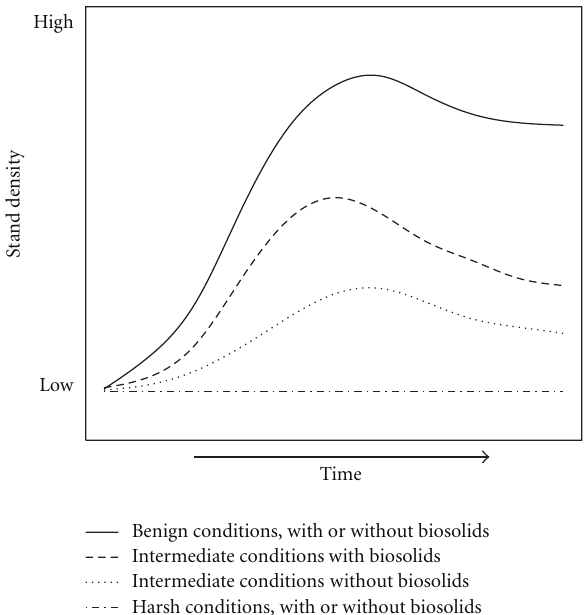
Figure 5: A conceptual model showing the e ff ects of topically applied biosolids on plant establishment under benign, intermedi- ate or harsh environmental conditions (redrawn from [10]).